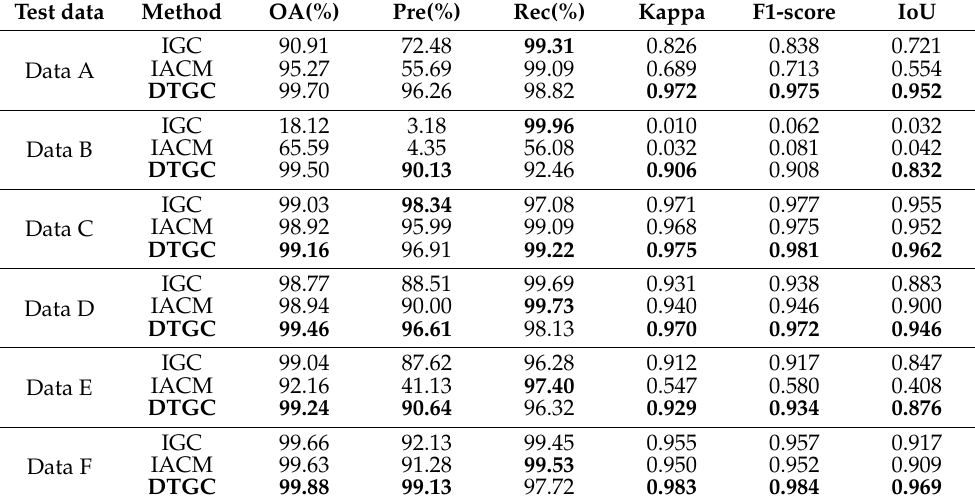
Table 5. Water body extraction accuracy of the various methods.